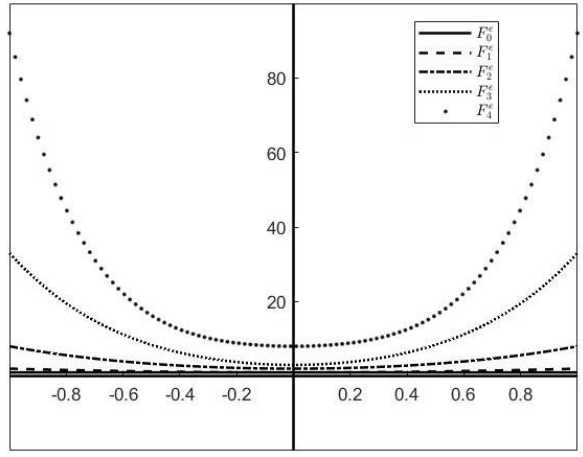
Figure 4. Even Fibonacci-central factorial